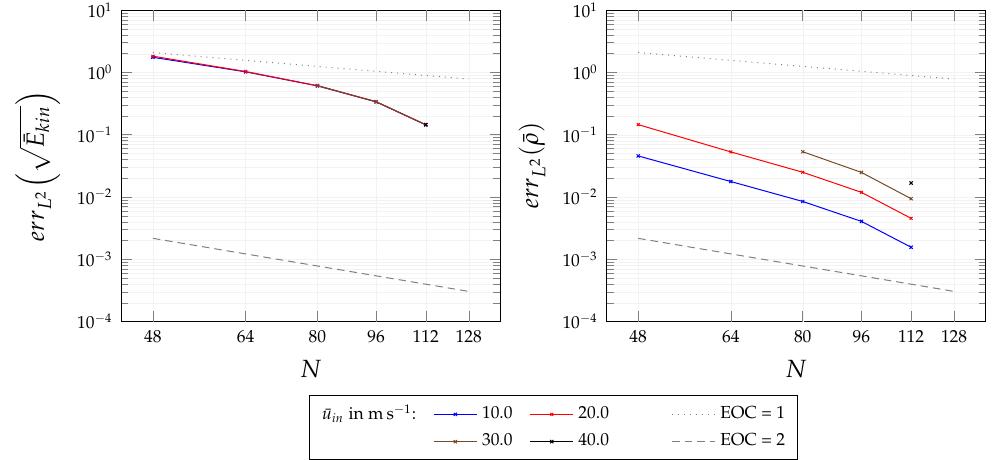
Figure 10. Error err L 2 of final values of average kinetic energy and average lattice density for different inflow velocities ¯ u in . Reference solution χ ref at N = 128. Quadratic and linear EOC as guidelines.